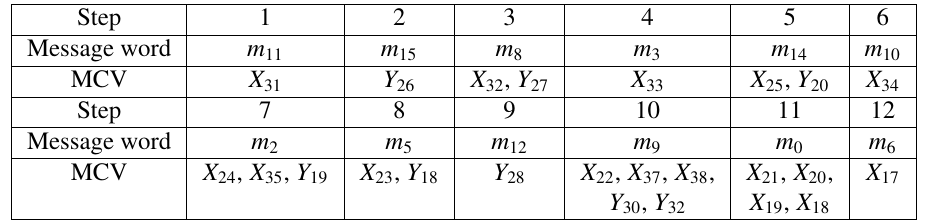
Table 3: The Process of Finding a Starting Point